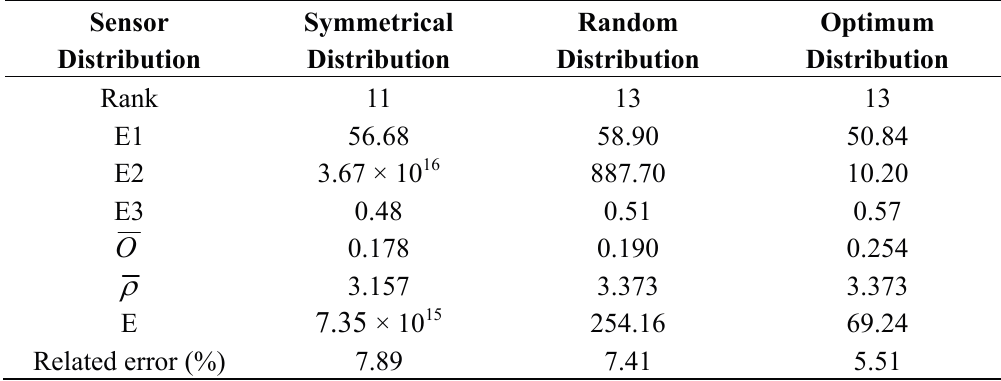
Table 4. Comparison of each index in different